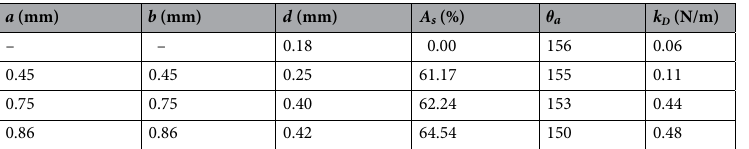
Table 1. Specification for wire mesh size adopted. a and b are horizontal and vertical wire spacings in a single 3 ( 1 − A s ) mesh cell, and d is mesh wire diameter or plate thickness, k D = E s d 12 ( 1 − v 2 ) is the mesh structure effective flexural stiffness, E is the mesh material elastic modulus, v is Poisson’s ratio and A s is open area aperture ratio. × 100% , p A s ( % ) = a × b 1 and p 2 are the gap of the centroid of two adjacent mesh p 1 × p 2